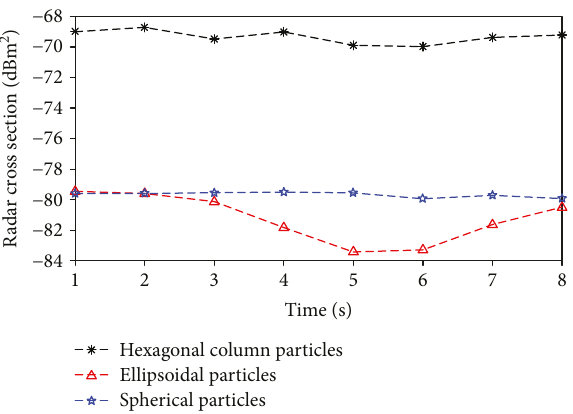
Figure 8: RCS fl uctuations of three particles detected by vertically pointing single radar.